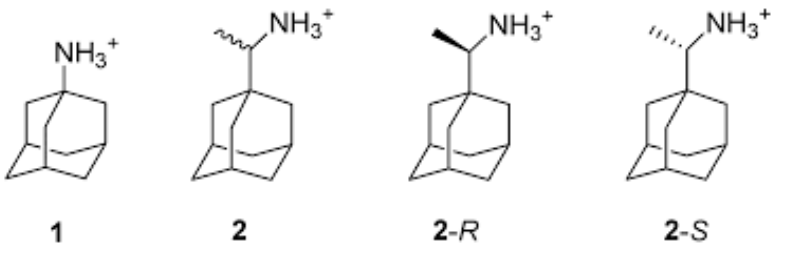
Figure 5. Adamantane and its amine analogues: amantadine ( 1 ), rimantadine ( 2 ), R -rimantadine ( 2 - R ) and S -rimantadine ( 2 - S ) (prepared by authors). ( 2 - R ) and S -rimantadine ( 2 - S ) (prepared by